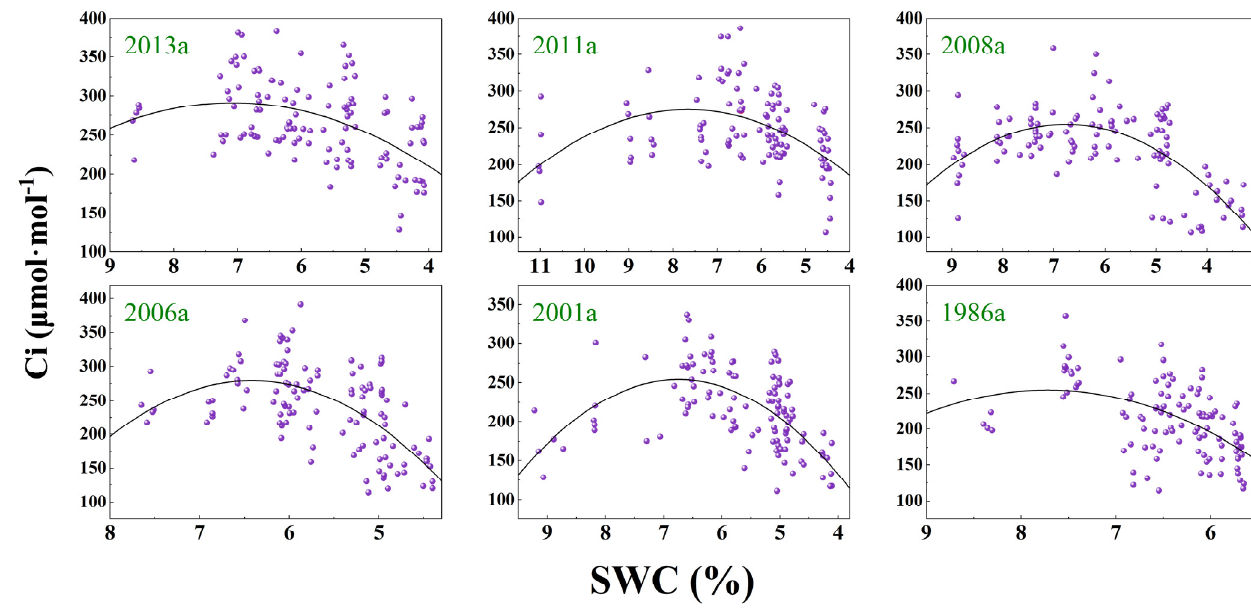
Figure 7. Regression fitting diagram of Ci and SWC.